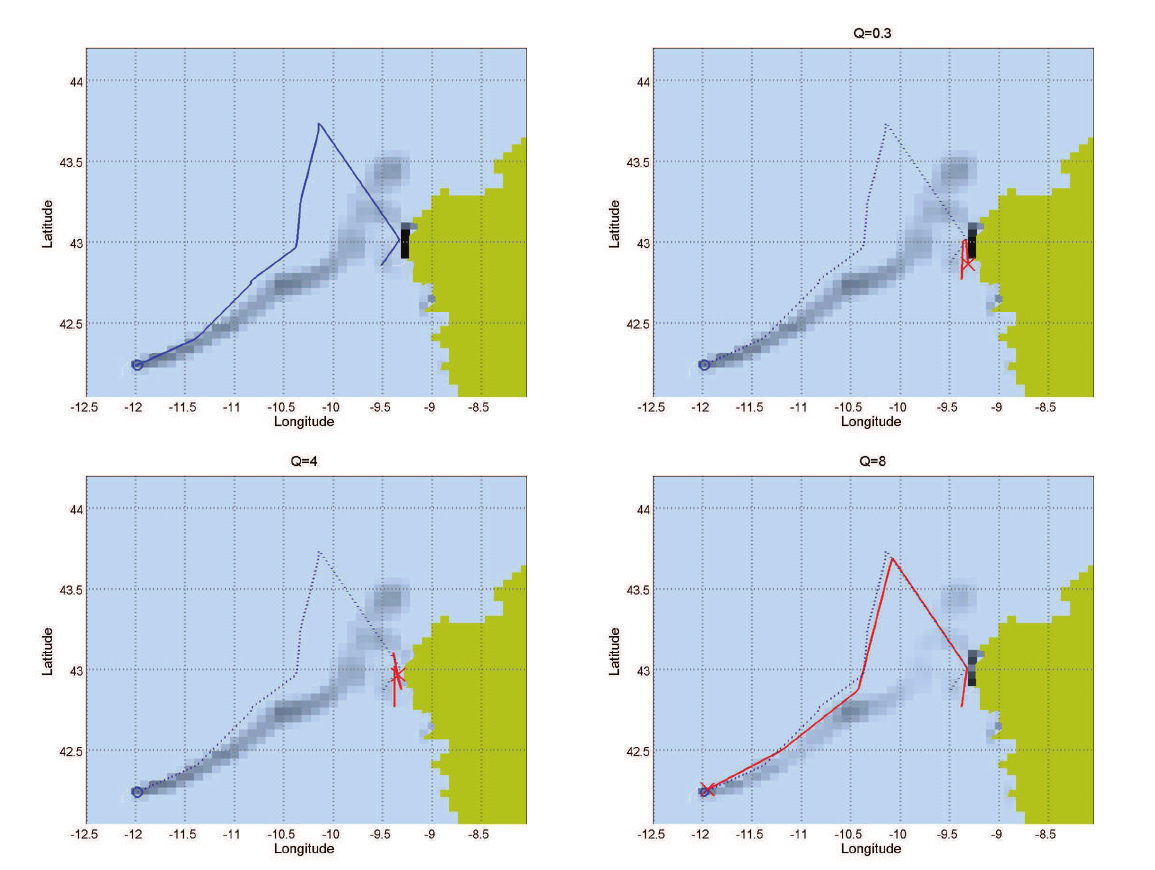
Fig. 5 Top view of the final oil concentration distribution at 19 November 2002, skimmer ship trajectory (continuous red line), final position of the skimmer ship (x) and final position of the Prestige ship (o) for the experiments: ( Top-Left ) trajectory of the Prestige ship (continuous blue line) with no pumping process, ( Top-Right ) OPT-0.3- (3), ( Bottom-Left ) OPT-4- (3) and ( Bottom Right ) OPT-8- (3). The trajectory of the Prestige ship is presented in dotted blue line.